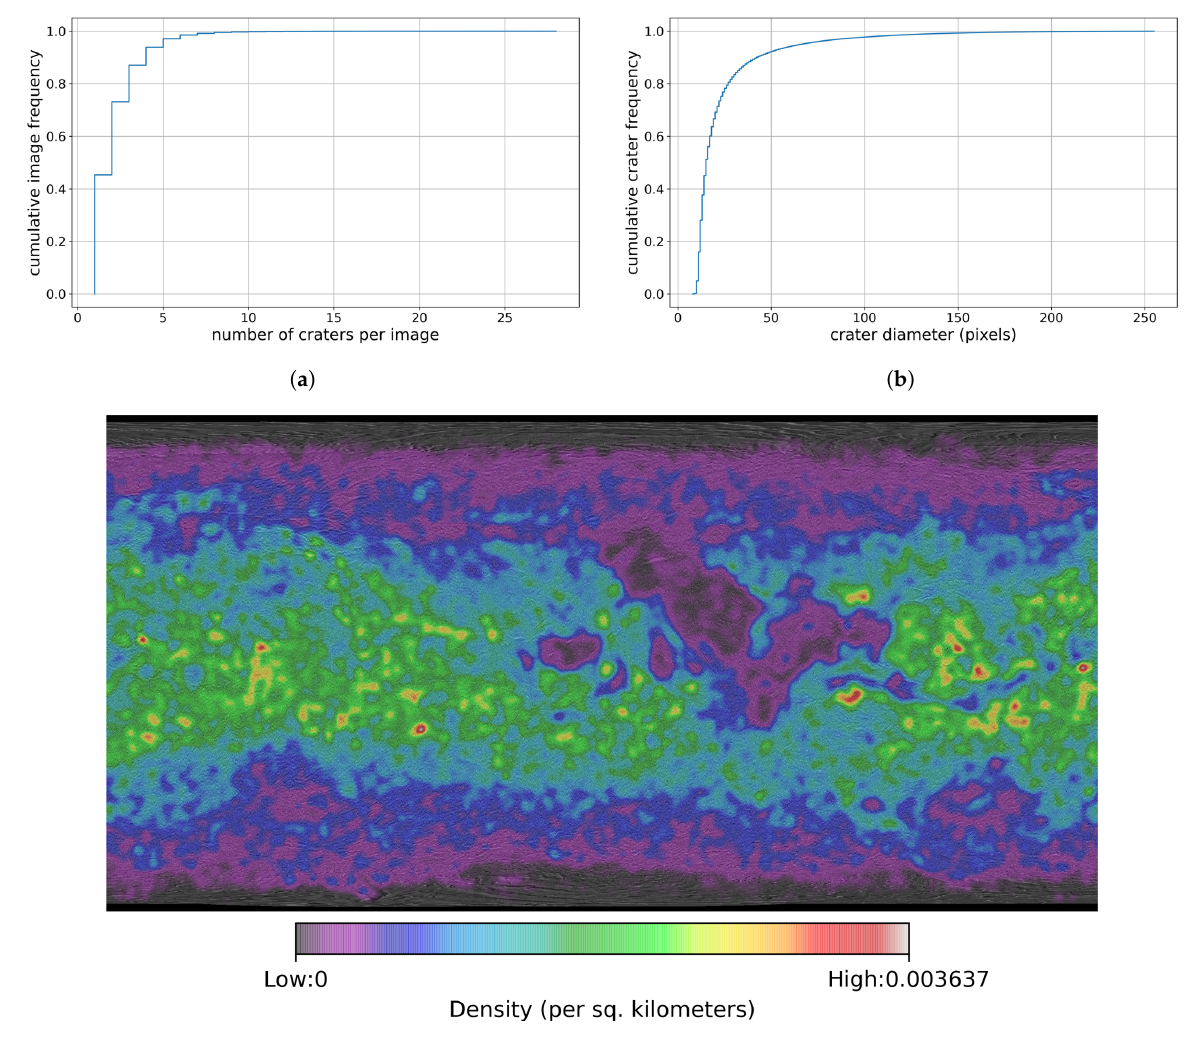
Figure 2. Statistics from the generated Mars crater dataset. Each pixel edge is 100 m. ( a ) The cumulative image frequency plot in terms of number of craters within each image; ( b ) The cumulative crater frequency plot in terms of crater sizes. One pixel represents an 100 m × 100 m area; ( c ) The heat map distribution of all the craters in our training